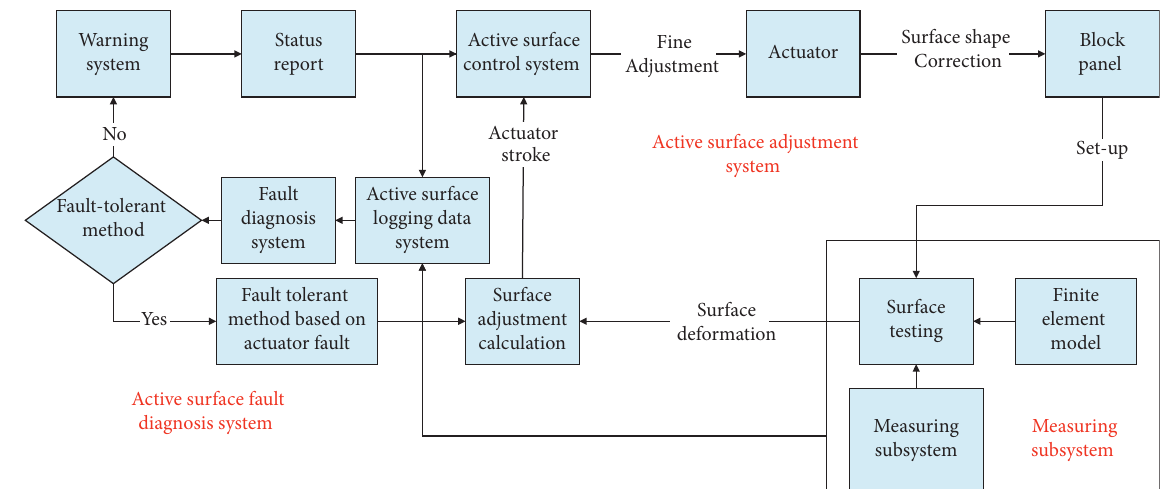
Figure 3: Active surface fault diagnosis flow